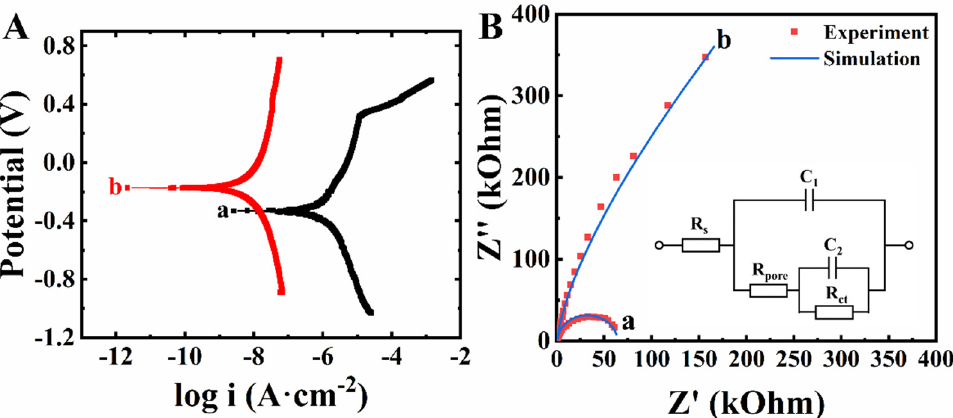
Figure 7. ( A ) Tafel plot, ( B ) Nyquist plot for substrate (a) without and (b) with coating; inset shows equivalent circuit. The working electrode area was 1 cm 2 . The coating was deposited from 1 gL ⁻ 1 CBXNa 2 with 10 gL ⁻ 1 PTFE in a mixed ethanol-water solvent at 50 V and annealed (1 h at 350 °C).